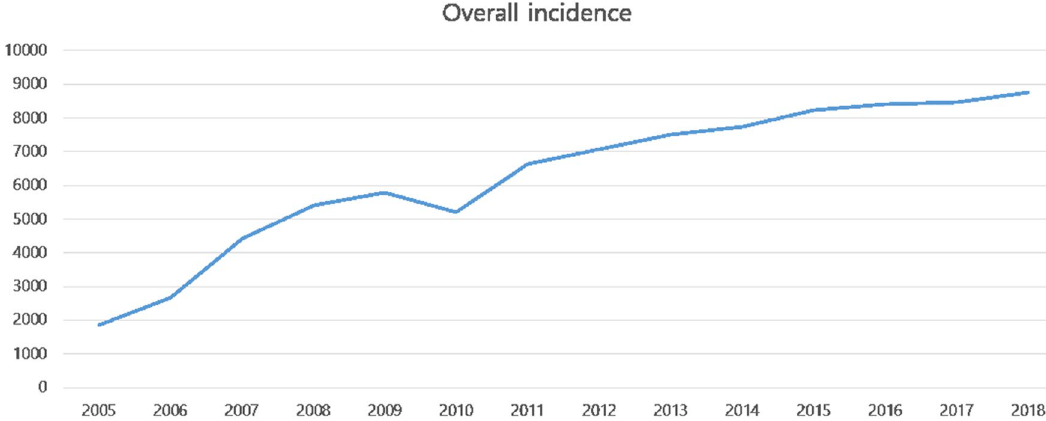
Figure 1. The incidence of septic knee arthritis by year.